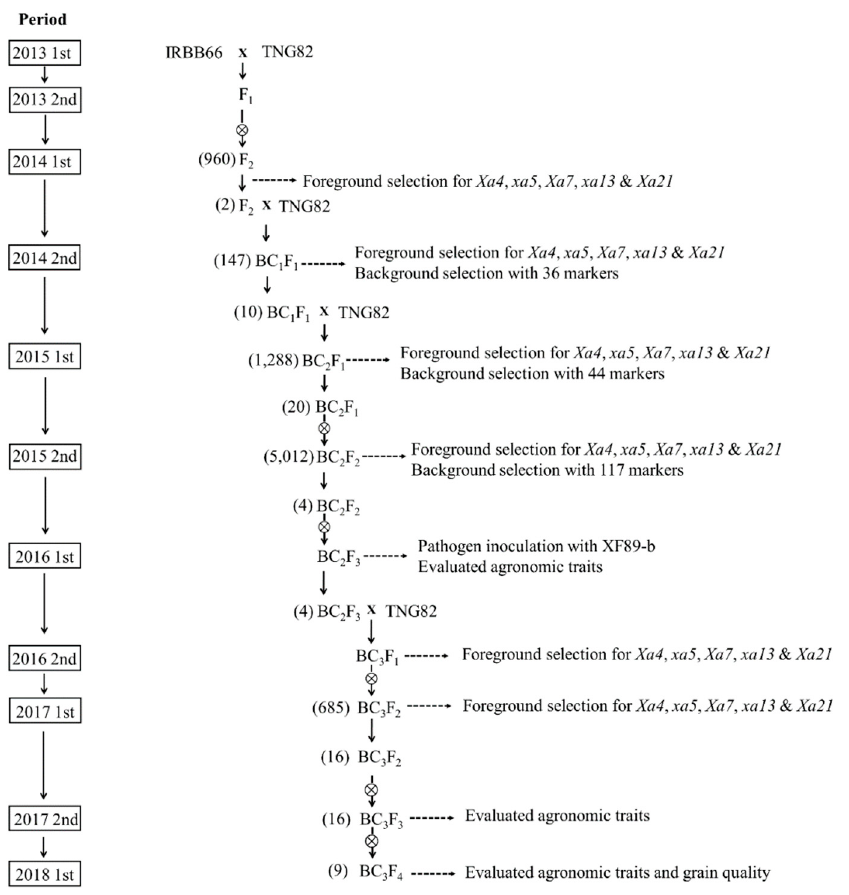
Figure 1. Schematic diagram for pyramiding bacterial blight resistance genes into Taiwanese japonica rice cultivar, TNG82, using marker-assisted selection and number of plants selected in every generation.